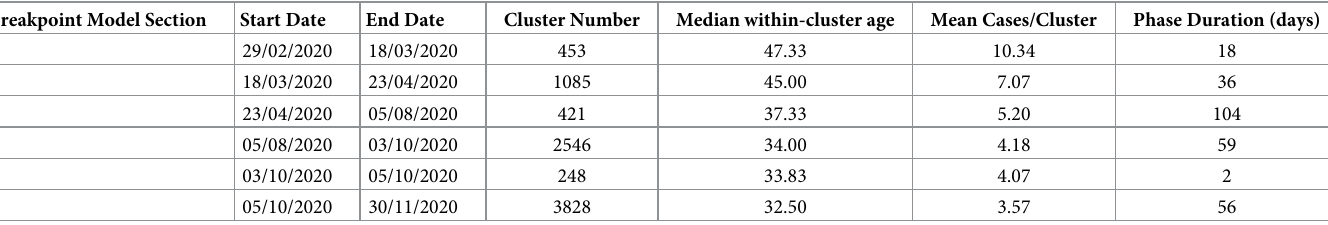
Table 4. Results of breakpoint modelling for COVID-19 clusters per day, with associated median within-cluster age and mean cluster size. Breakpoint Model